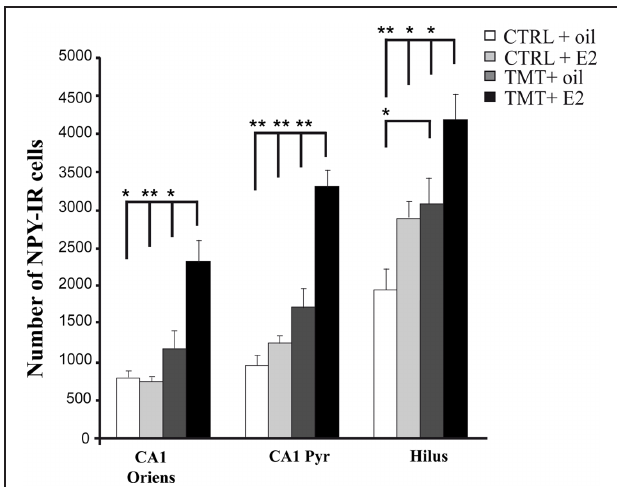
FIGURE 7 | Quantitative analysis of neuropeptide Y (NPY)-positive neurons in CA1 stratum oriens, CA1 pyramidal layer and hilus of the different experimental groups. Bar graphs indicate that a significantly higher number of NPY-IR cells is evident in the hilus of the TMT + oil-treated group compared with CTRL + oil-treated animals. The TMT + E2-treated group shows a significant increase in the number of NPY-IR cells in CA1 stratum oriens, CA1 pyramidal layer and in the hilus compared with TMT + oil-treated animals and both control groups. The values are given as means ± SE ( ∗ p < 0.05, ∗∗ p <